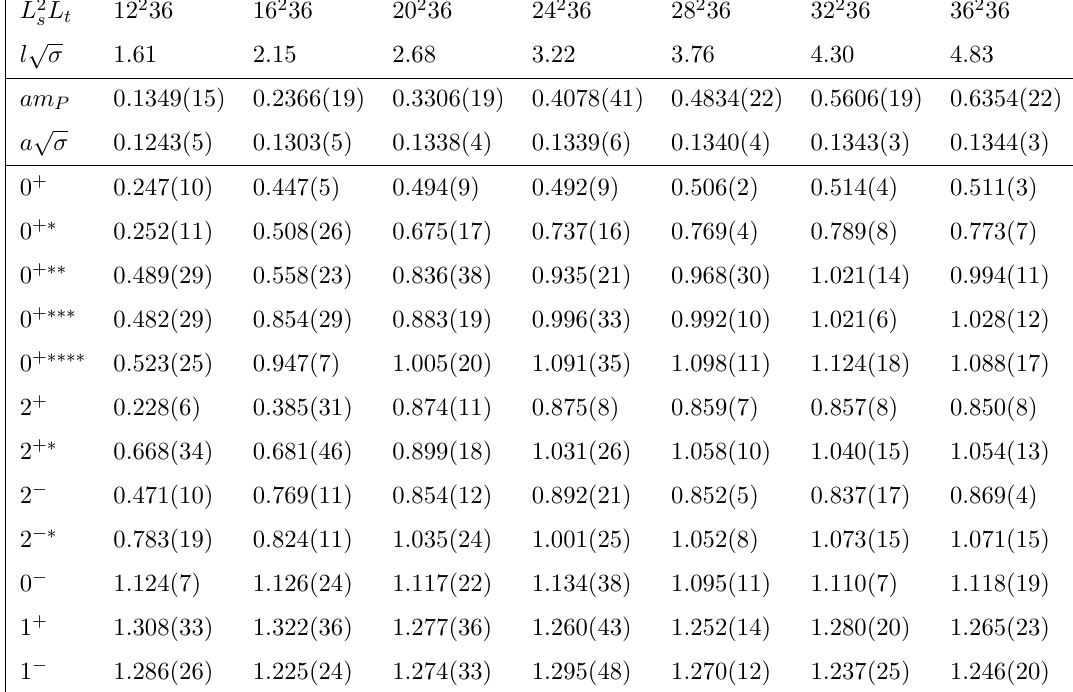
Table 3 . Glueball masses, am G , and the (cid:13)ux loop energy, am P , with corresponding string tensions p a (cid:27) extracted using the Nambu-Goto formula in eq. (3.5). On various volumes at (cid:12) = 84 in